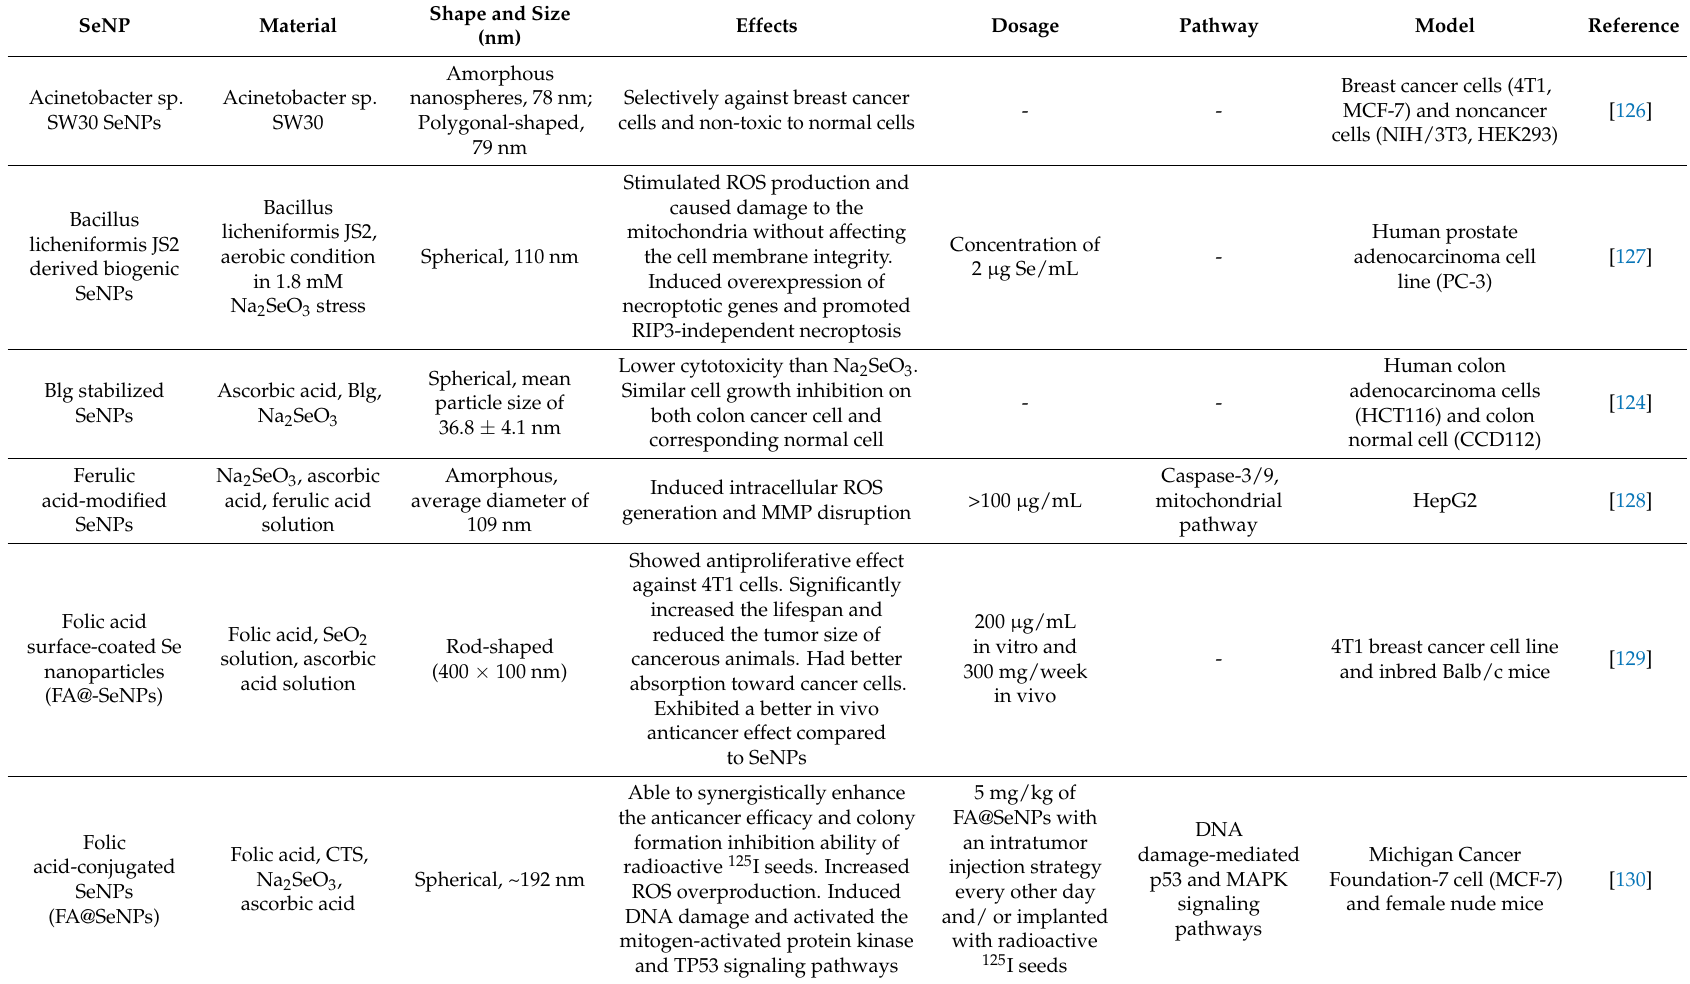
Table 1. Summary of recent work on Se-containing nanoparticles (SeNPs) with potential in cancer